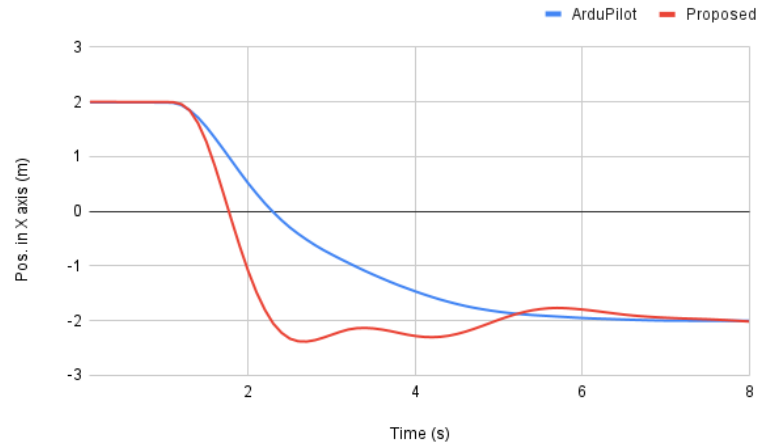
Figure 8. ArduPilot and Proposed method compared.